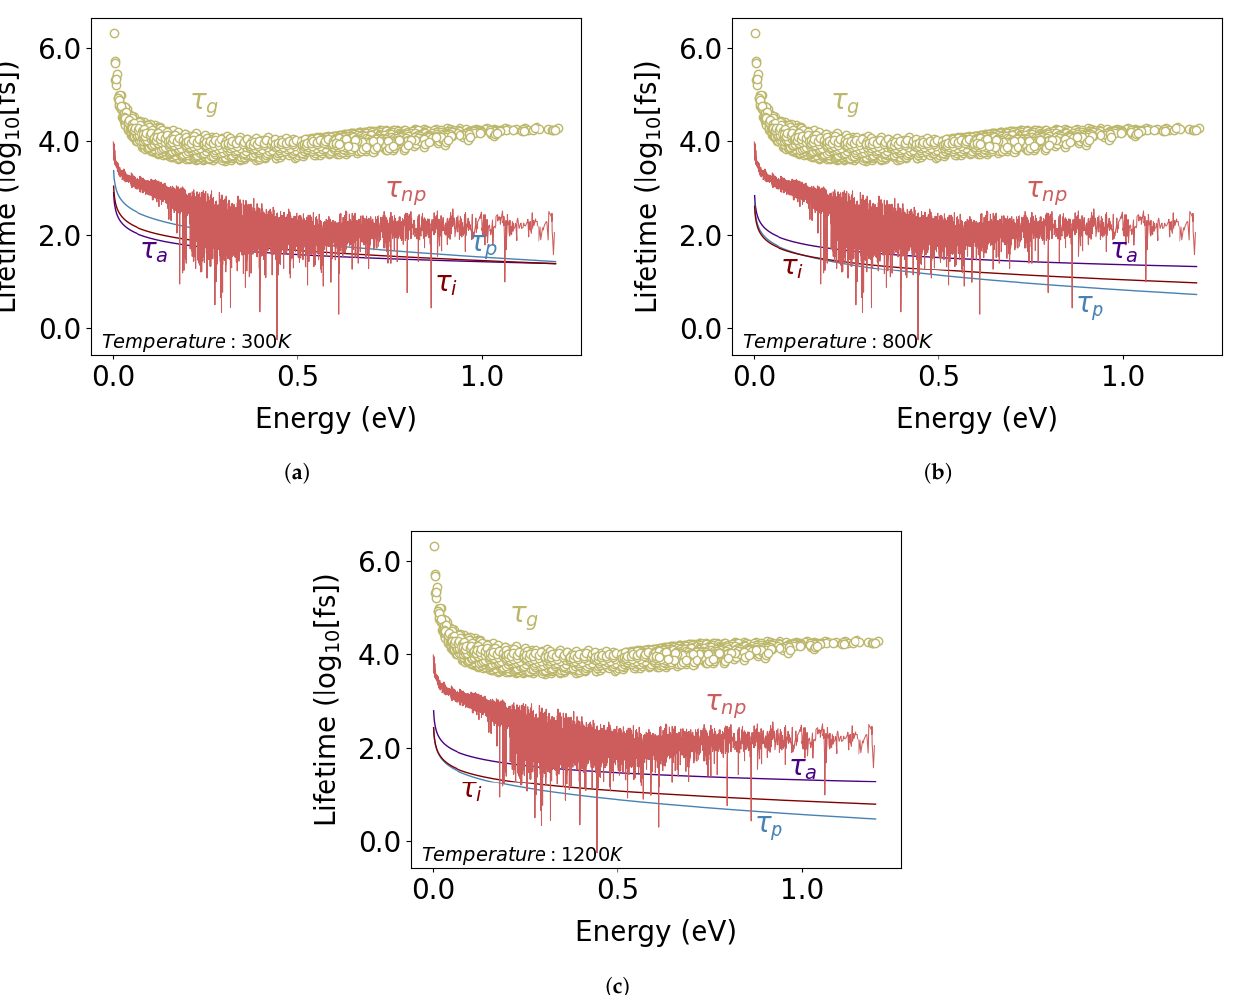
Figure A4. Electron lifetime for the different scattering mechanisms in Si 0.8 Ge 0.2 at ( a ) 300 K, ( b ) 800 K, and ( c ) 1200 K, with a carrier population of 10 20 1/cm 3 . The grains effective length is 50 nm. The pore–pore spacing is 20 nm for 25%